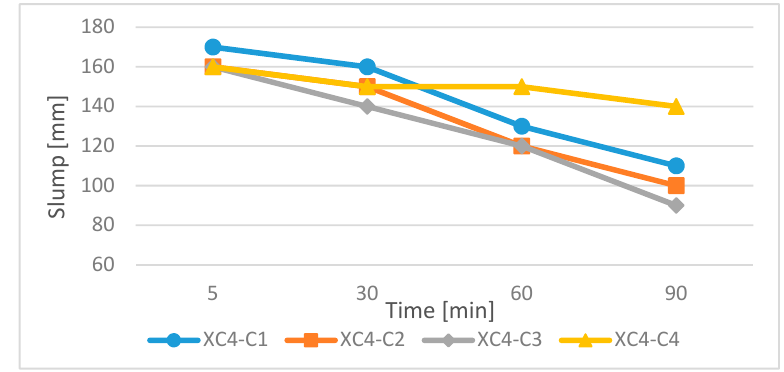
Figure 4. Consistency of concrete mixtures XC4 in time.